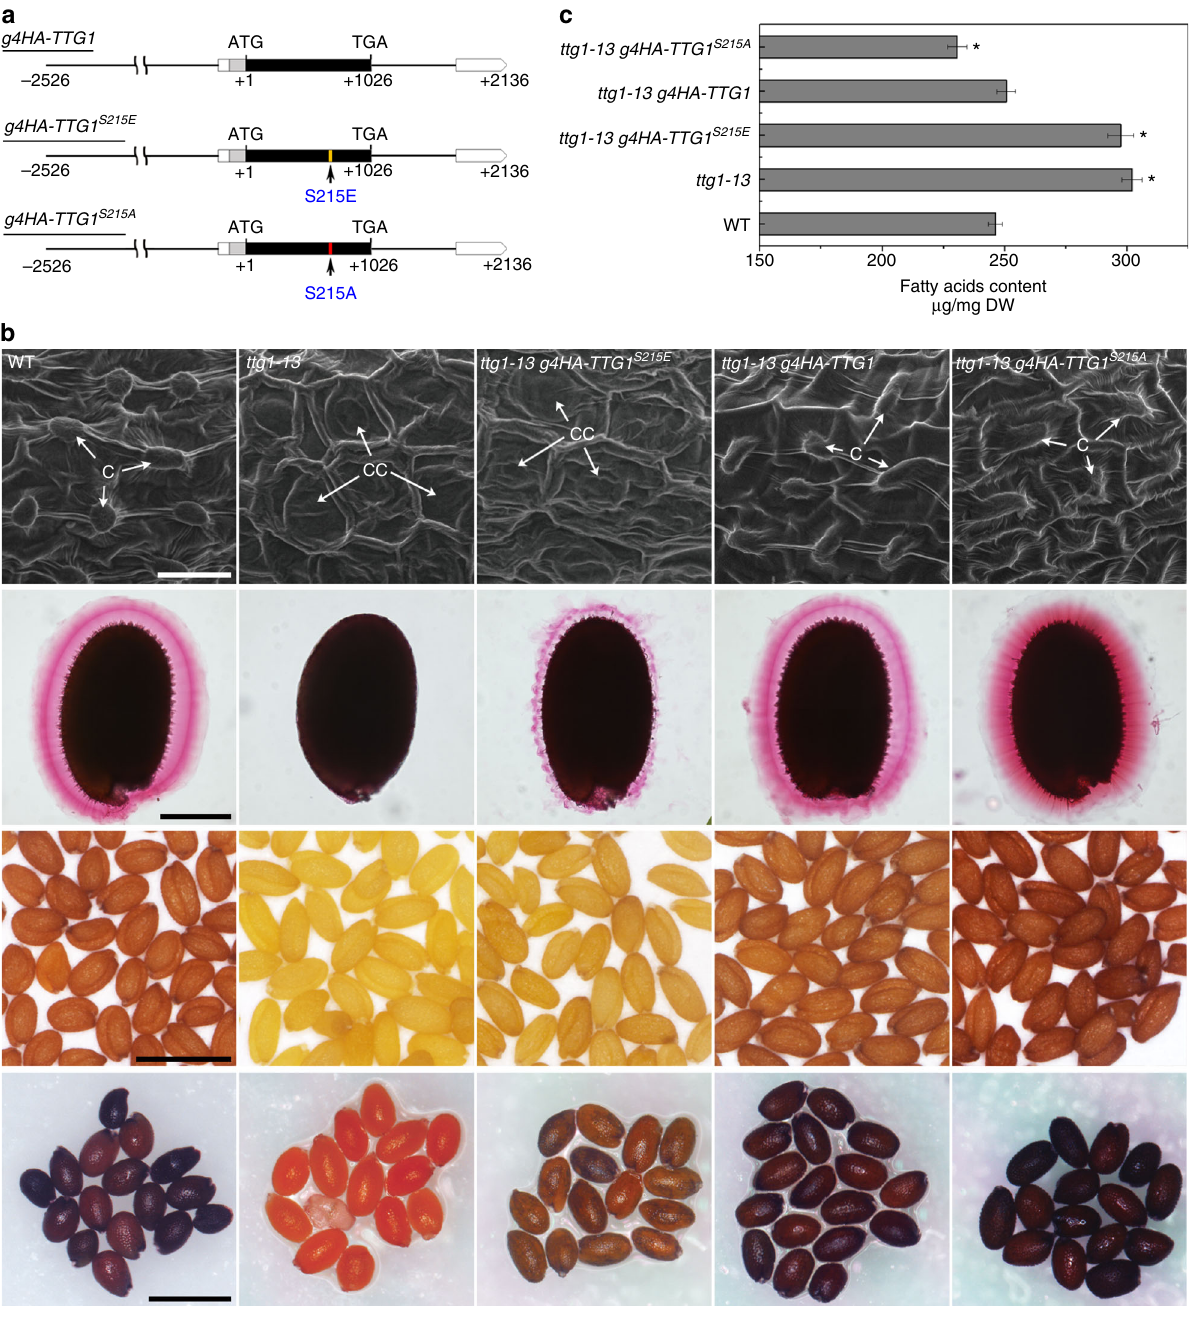
Fig. 5 Phosphorylation of TTG1 at Ser 215 abolishes its activity in regulating seed characters. a Schematic diagram of the phosphorylation-mimicking construct g4HA-TTG1 S215E and the dephosphorylation-mimicking construct g4HA-TTG1 S215A . The coding and untranslated regions of TTG1 are indicated by black and white boxes, respectively, while an intron and other genomic regions are indicated by black lines. The 4HA tag represented by a gray box is fused to the N terminus of TTG1. The fi rst nucleotide of the translation start codon is assigned the +1 position, and other sequences are numbered relative to this site. Arrow indicates the site containing a point mutation from S to E or S to A at Ser 215. b Examination of seed coat phenotypes of mature Arabidopsis seeds in various genetic backgrounds. SEM of seed coat ( fi rst row), seed coat mucilage staining with ruthenium red (second row), seed color (third row), and seed staining with DMACA (fourth row) are shown in panels from top to bottom. Scale bars, 25 μ m, 200 μ m, 1 mm, and 1 mm (from top to bottom). In SEM panels, “ C ” indicates columella, while “ CC ” indicates collapsed columella. c Measurement of total fatty acid contents of mature seeds in various genetic backgrounds. Values are mean ± s.d. of three biological replicates. Asterisks indicate signi fi cant differences between wild-type and samples in other genetic backgrounds (two-tailed paired Student ’ s t test, P < phosphorylation of TTG1 at Ser 215, which is conserved among reduced PA deposition, and signi fi cantly increased fatty acid TTG1 orthologs in various plant species (Supplementary Fig. 14a, levels compared to wild-type seeds, whereas ttg1-13 g4HA - b), by SK11 and SK12 inhibits formation of seed mucilage and TTG1 S215A displayed opposite seed phenotypes, resembling those fl avonoid pigments, but promotes synthesis of fatty acids, of sk11 sk12 (Figs. 3a and 5b, c). These results demonstrate that